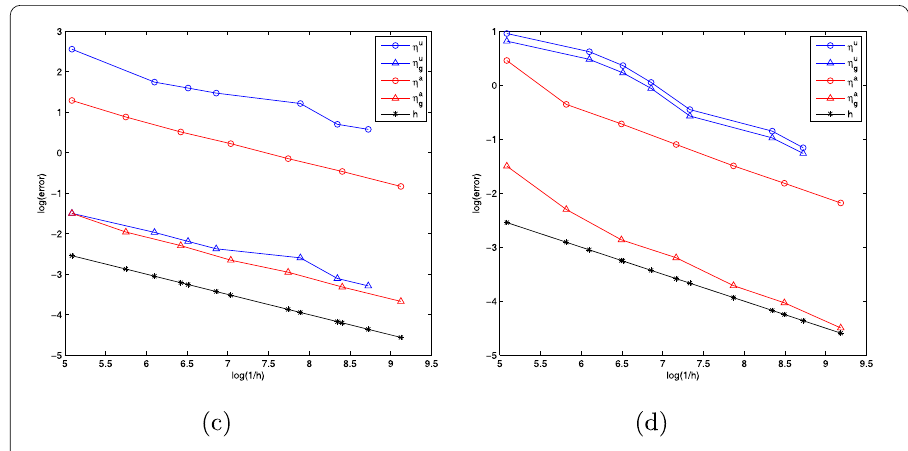
Figure 4 The convergence rate of adaptive and uniform refinements for the problem on L-shape domain with slip boundary condition: g is discontinuous at (0,0). ( c ): P 1 – P 0 ; ( d ): P 1 – P